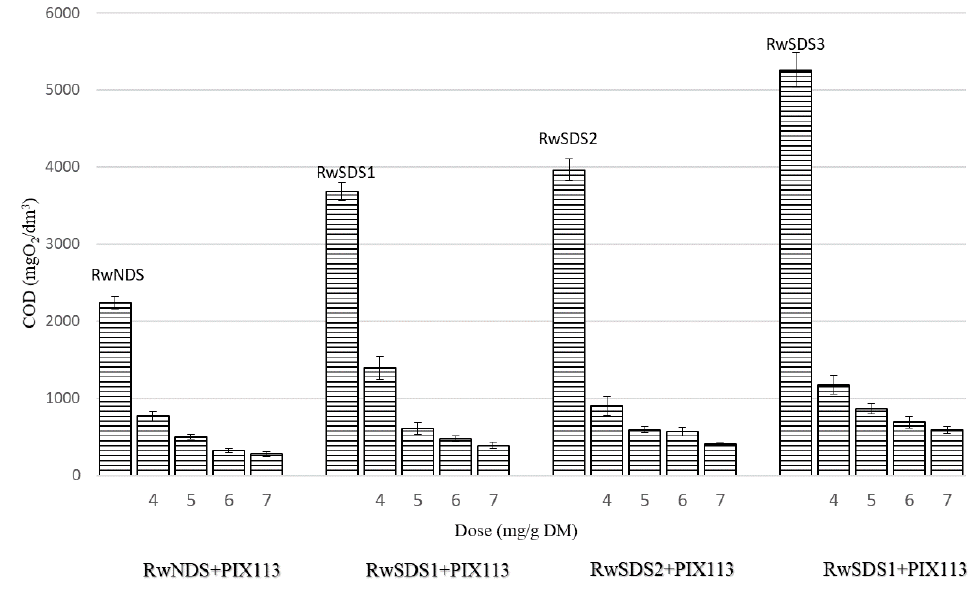
Figure 2. Changes of the COD in the reject water separated from sludge prepared with PIX 113.